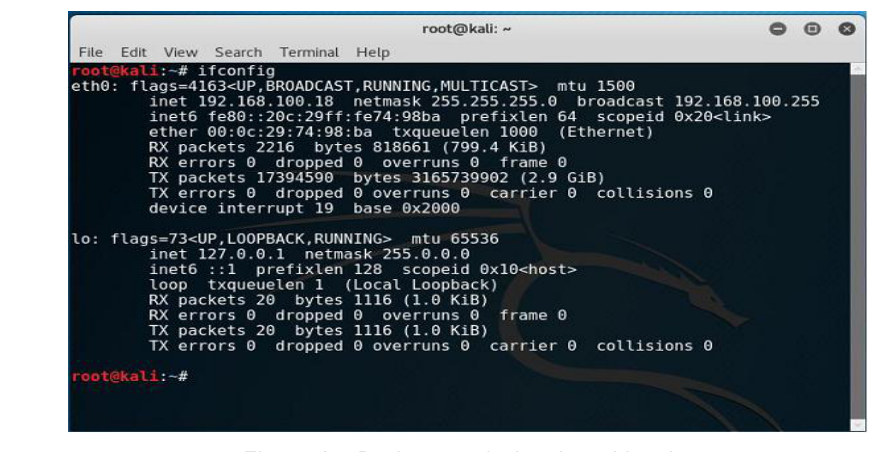
Figure 2 – Basic network virtual machine data Рис . 2 – Базовые данные на виртуальной